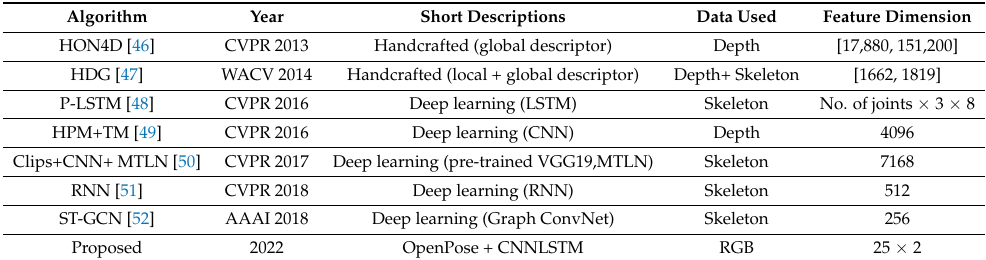
Table 8. Comparison of feature